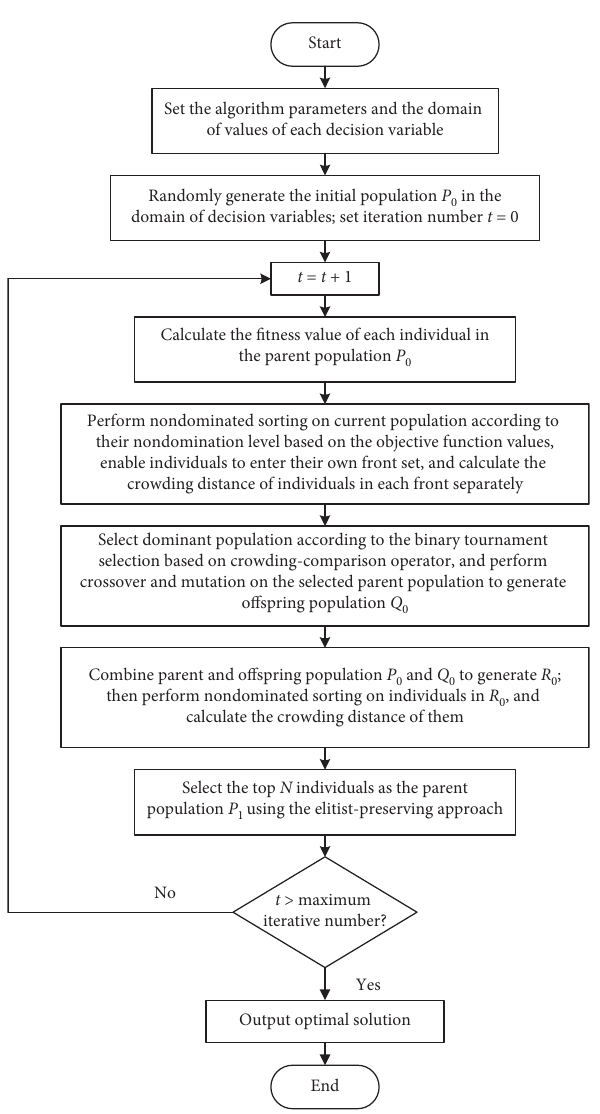
Figure 4: Flowchart of NSGA-II algorithm